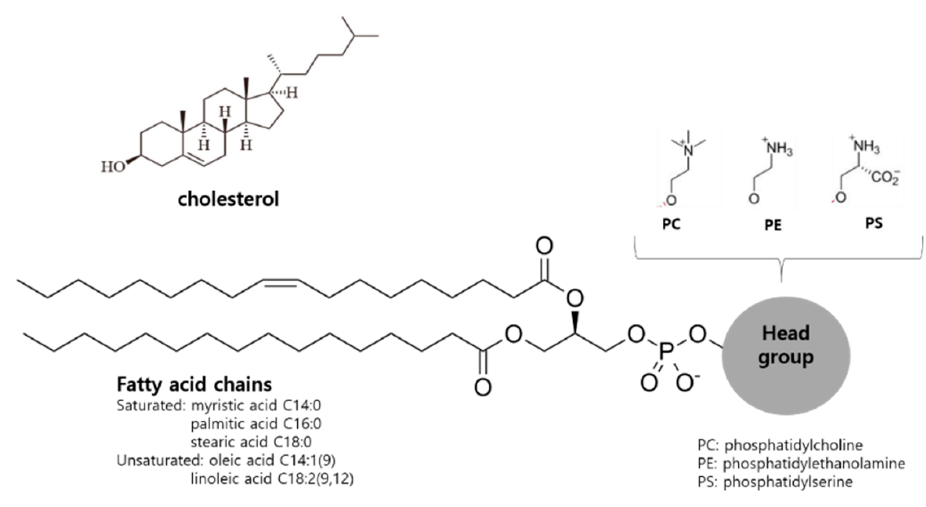
Figure 2. Structure of phospholipids and cholesterol.